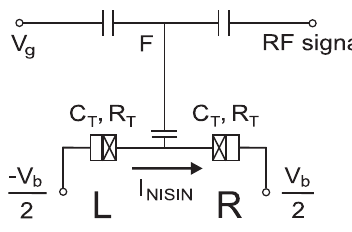
Figure 1. Equivalent circuit of the NISIN detector. The microwave (RF) signal and the DC tuning voltage, V g , are capacitively coupled to the superconducting island through the floating gate F. NIS tunnel junctions, each with resistance R T and capacitance C T , are formed between superconducting (Al, crossed boxes) and normal conducting (AuPd, open boxes) electrodes.